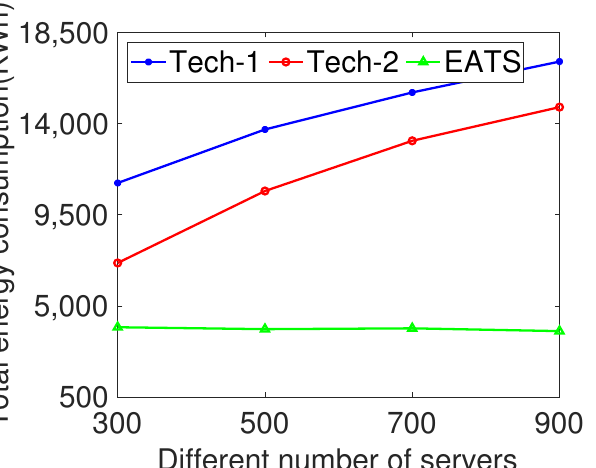
Figure 13. Comparison of total energy consumption with different number of servers for Alibaba cluster data.